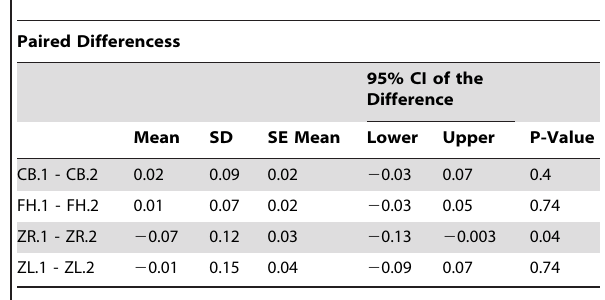
Table 2. Mean differences (mm) and 95% confidence interval (CI) between first and second superimposition registered on the anterior cranial base.